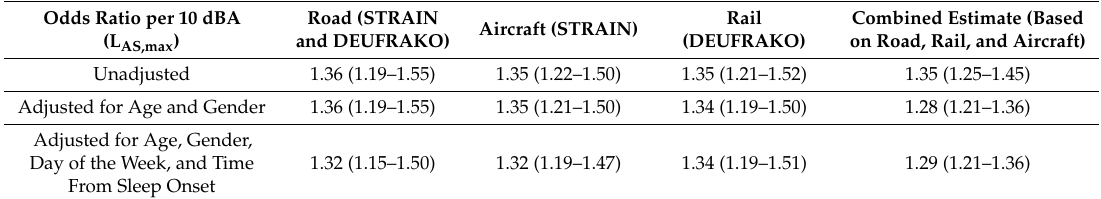
Table 1. Odds Ratios and 95% confidence intervals for sleep stage transitions to awake or Stage 1 for road, rail, and aircraft noise for a 10 dBA increase in the indoor maximum noise level (L AS,max ). Number of subjects contributing to the analysis: Road = 94, Aircraft = 61, Rail = 33.